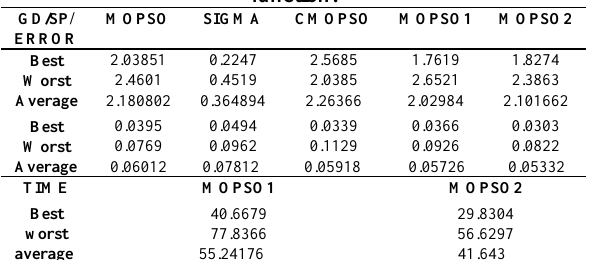
Table 2: GD/SP/ERROR/TIME result for second function. GD/SP/